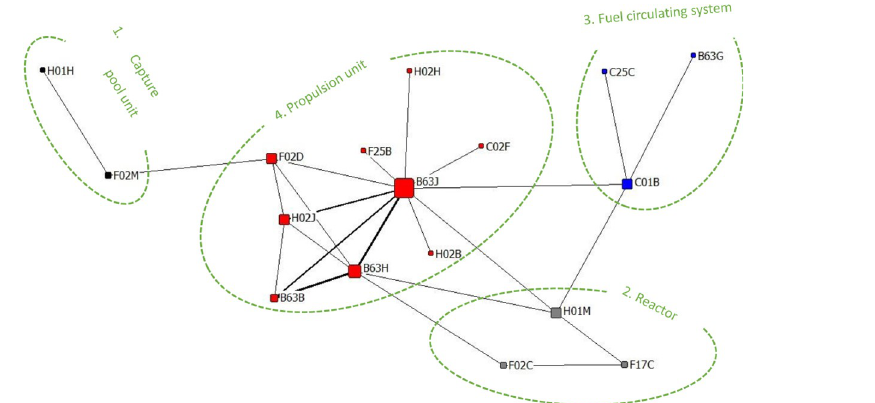
Fig 6. DEWO-C patented co-occurrence network